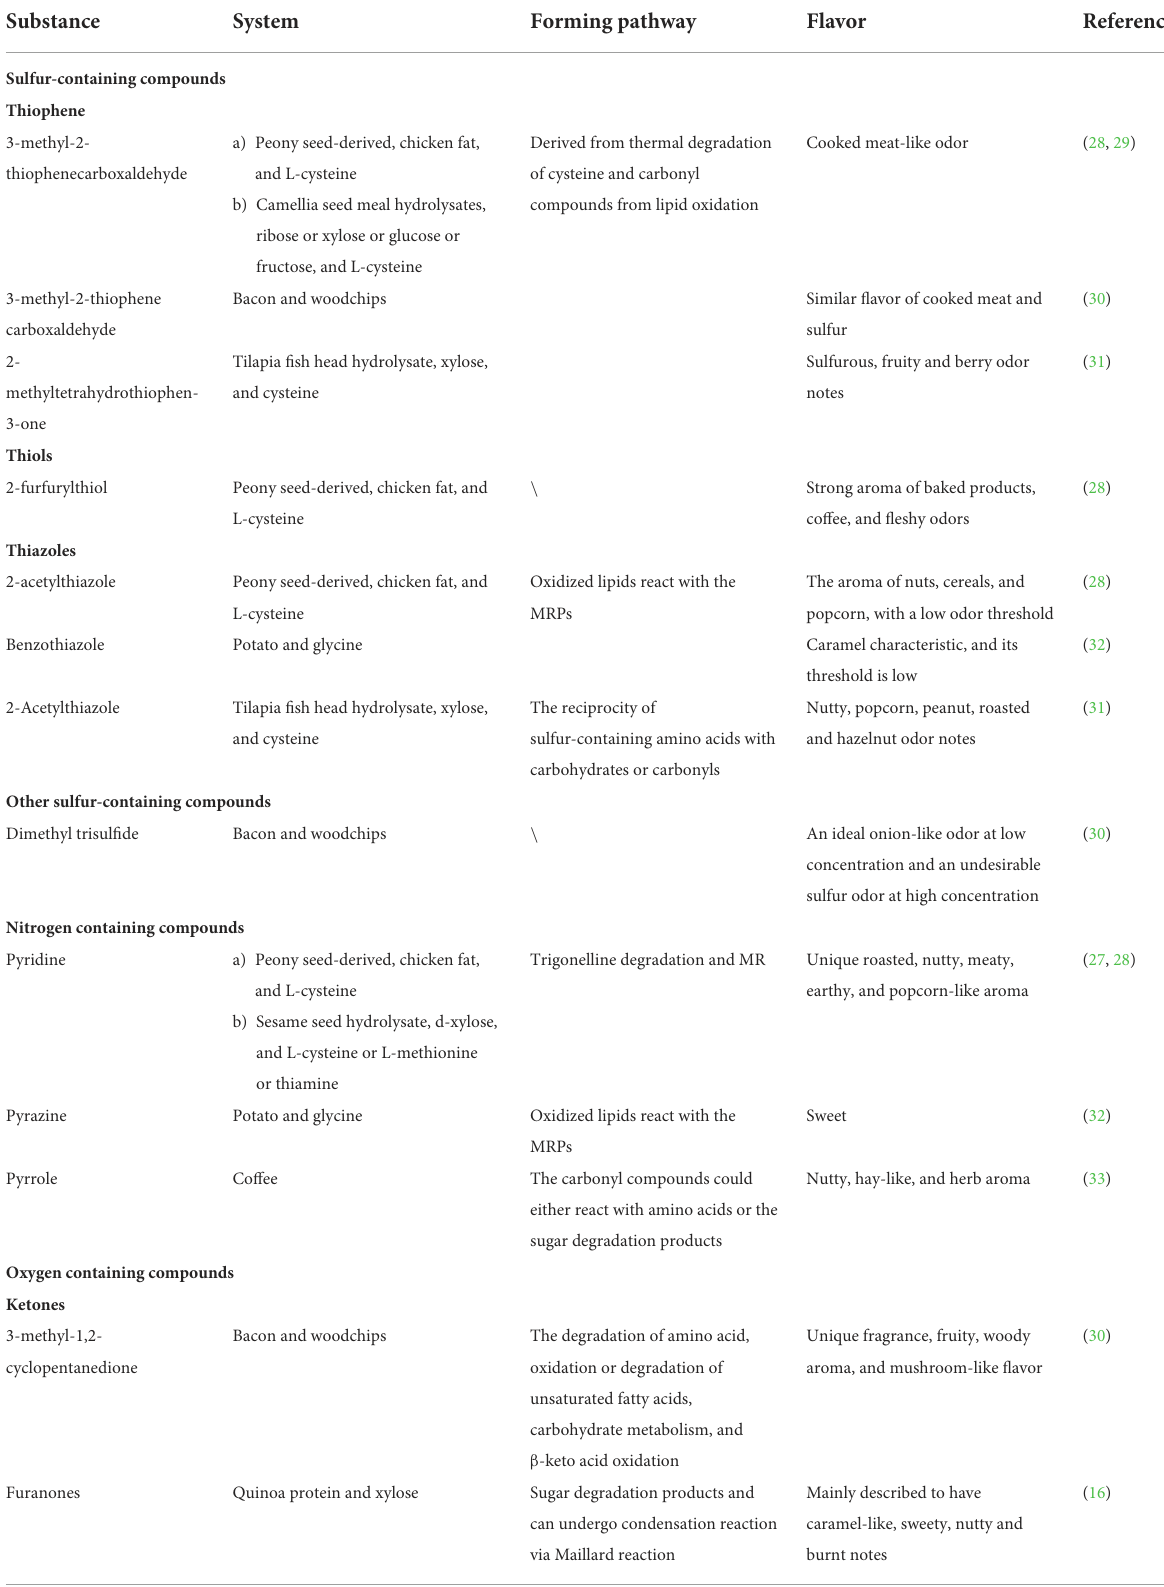
TABLE 1 Flavor characteristics and forming pathway of flavor products. Substance System Forming pathway